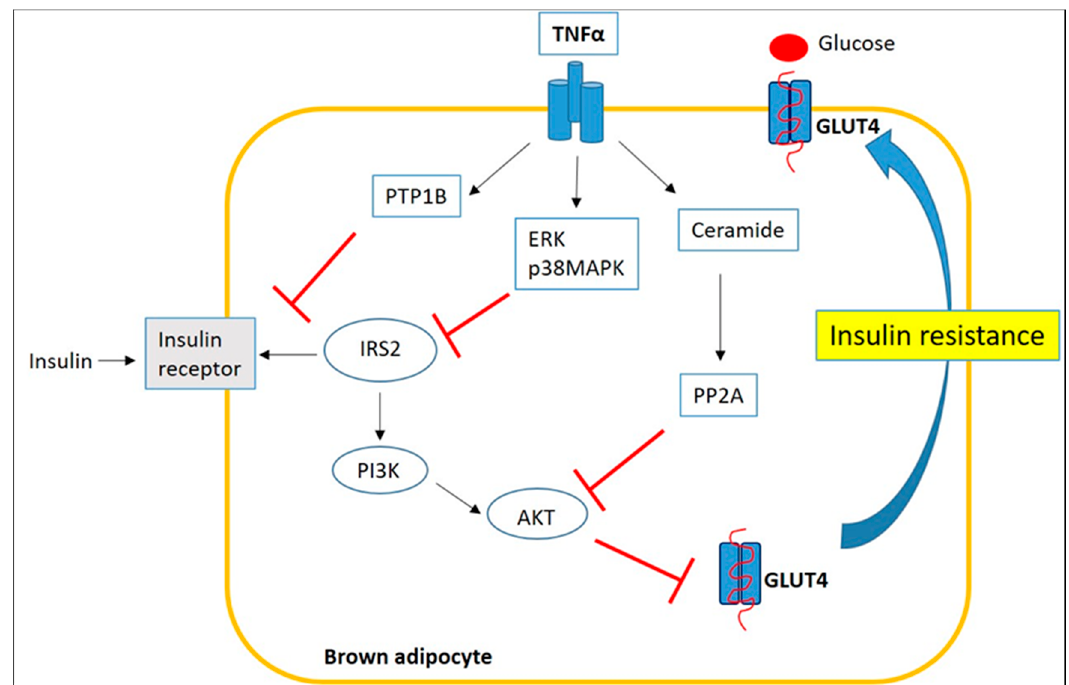
Figure 5. Inflammatory signaling impairs insulin sensitivity of BAT through a TNF α -mediated mechanism.